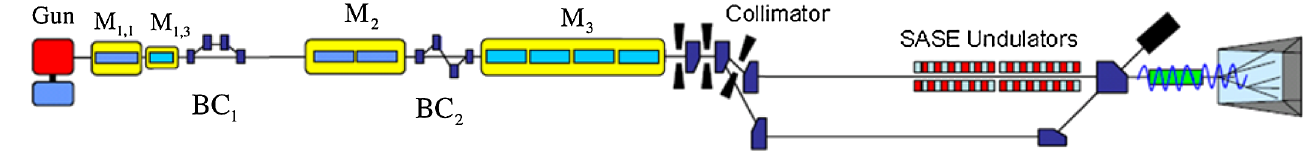
FIG. 4. The layout of the FLASH